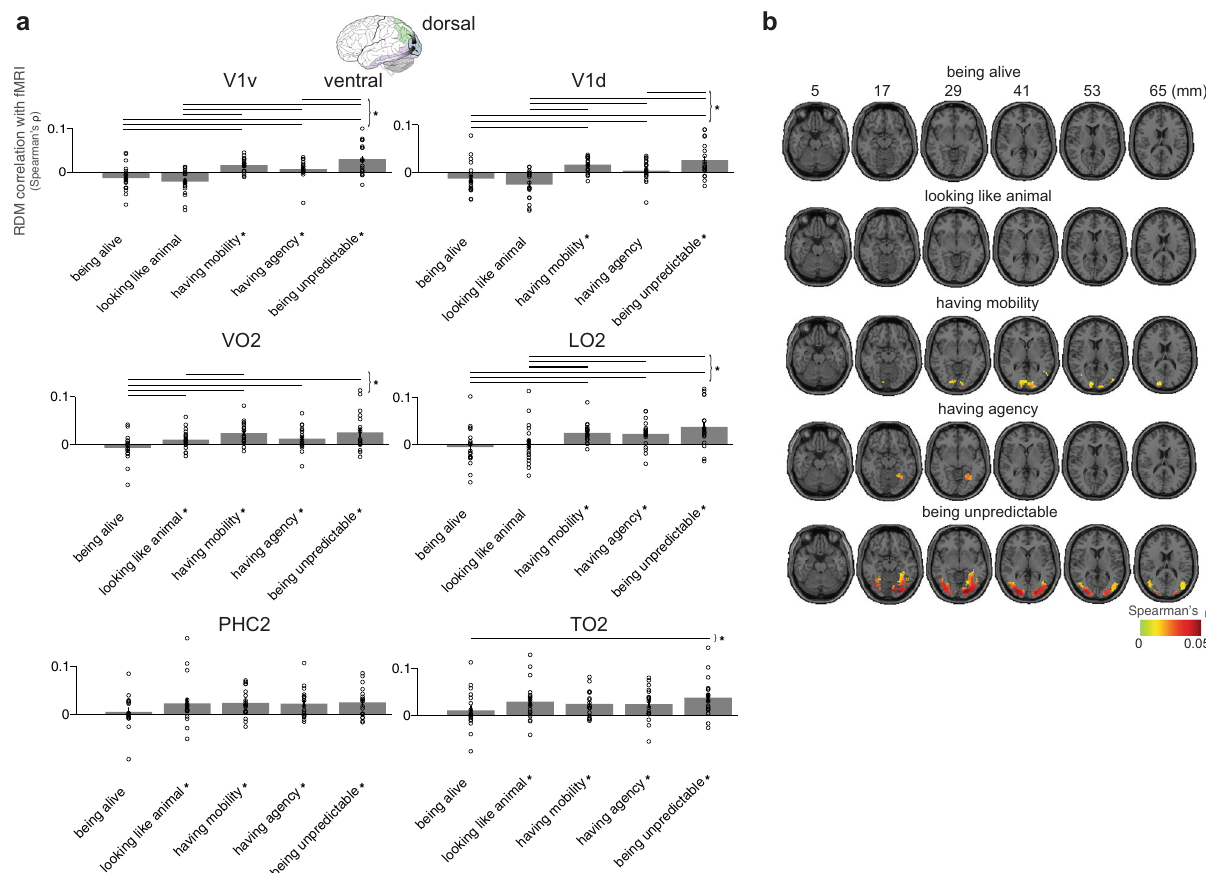
Fig. 7 Dimensions of animacy and fMRI responses. a Animacy dimension RDM comparisons with fMRI ROI RDMs of 19 participants. Bars show the correlation between each animacy dimension RDM with fMRI ROI RDMs. We selected ROIs across the ventral (V1v, VO2, PHC2) and dorsal (V1d, LO2, TO2) visual streams. A signi fi cant correlation is indicated by an asterisk (one-sided Wilcoxon signed-rank test, p < 0.05 corrected). Error bars show the standard error of the mean based on single-participant correlations, i.e., correlations between the single-participant ROI RDMs and animacy dimension RDM. Circles show single-participant correlations. Horizontal lines show signi fi cant pairwise differences between model performance ( p < 0.05, FDR corrected across all comparisons), an asterisk to the right of horizontal lines indicates their signi fi cance. b Searchlight analysis with each animacy dimension showing where in the brain animacy dimensions explain image representations masked with the visual stream regions (Spearman ’ s ρ between animacy dimension and brain representations, one-sided Wilcoxon signed-rank test, FDR controlled at